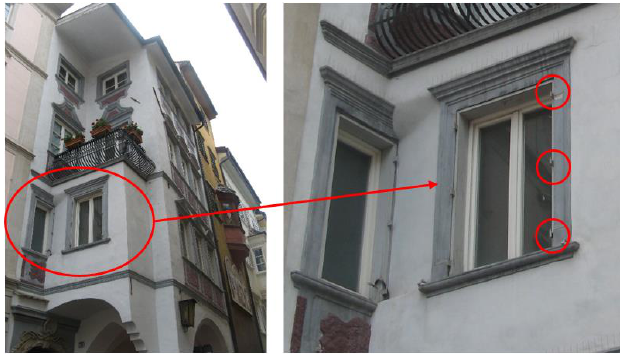
Figure 15. The previous hinges of wooden shutter in Piazza Erbe 11.